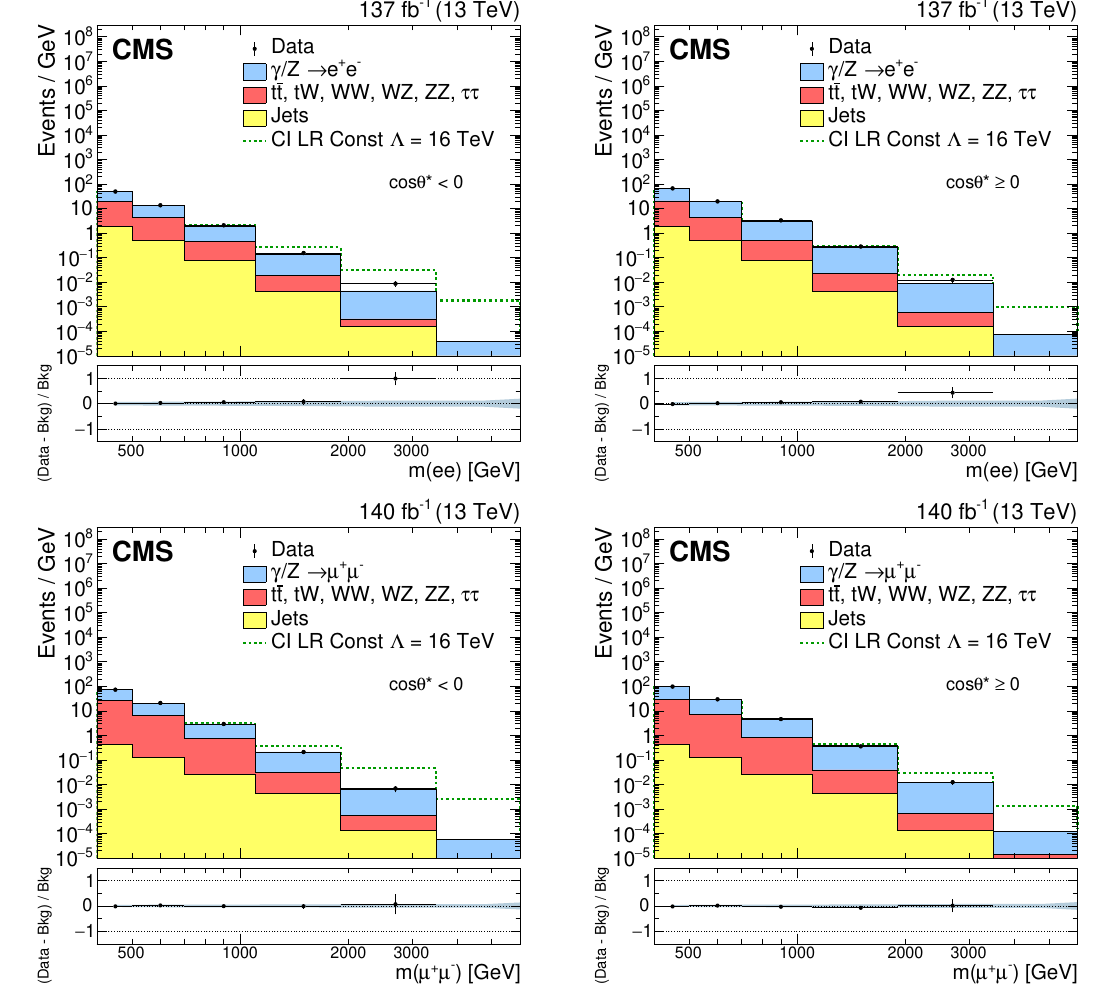
Figure 3 . The invariant mass distribution of pairs of (upper) electrons and (lower) muons ob- served in data (black dots with statistical uncertainties) and expected from simulated SM processes (stacked histograms) for (left) cos θ ∗ < 0 and (right) cos θ ∗ ≥ 0 . The bin width gradually increases with mass. The ratios of the data yields after background subtraction to the expected background yields are shown in the lower plots. The blue band represents the combined statistical and system- atic uncertainties in the background. The signal contributions expected from the constructive LL CI model with Λ = 16 TeV are shown as dashed green